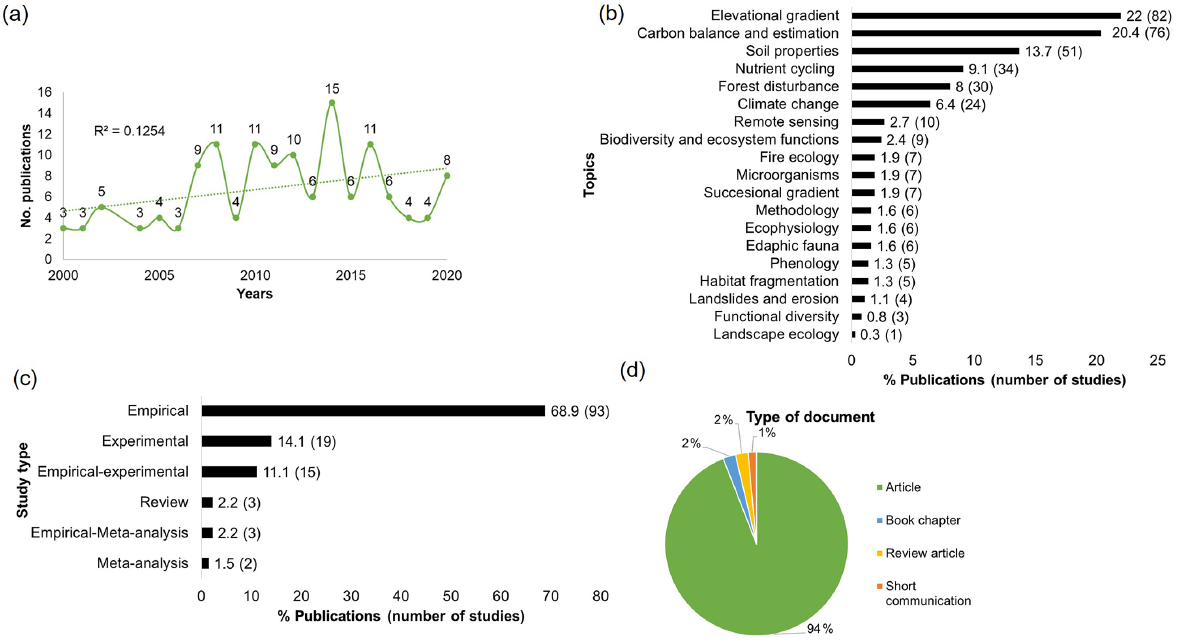
Figure 2. Bibliographic information of carbon cycle in upland tropical ecosystems. (a) Years, (b) topics, (c) type of study, and (d) type of document.